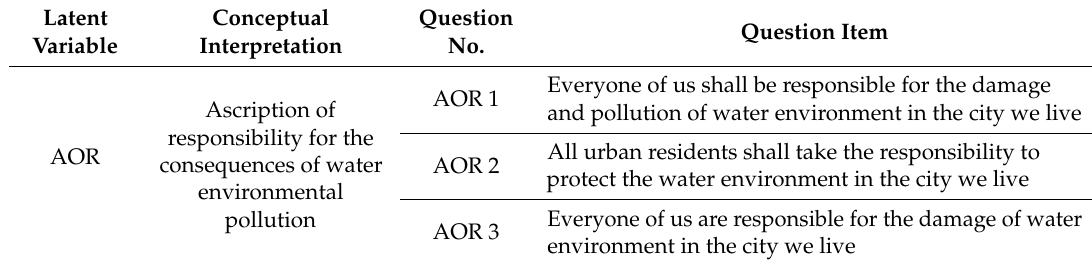
Table 5. Measurement table for AOR.